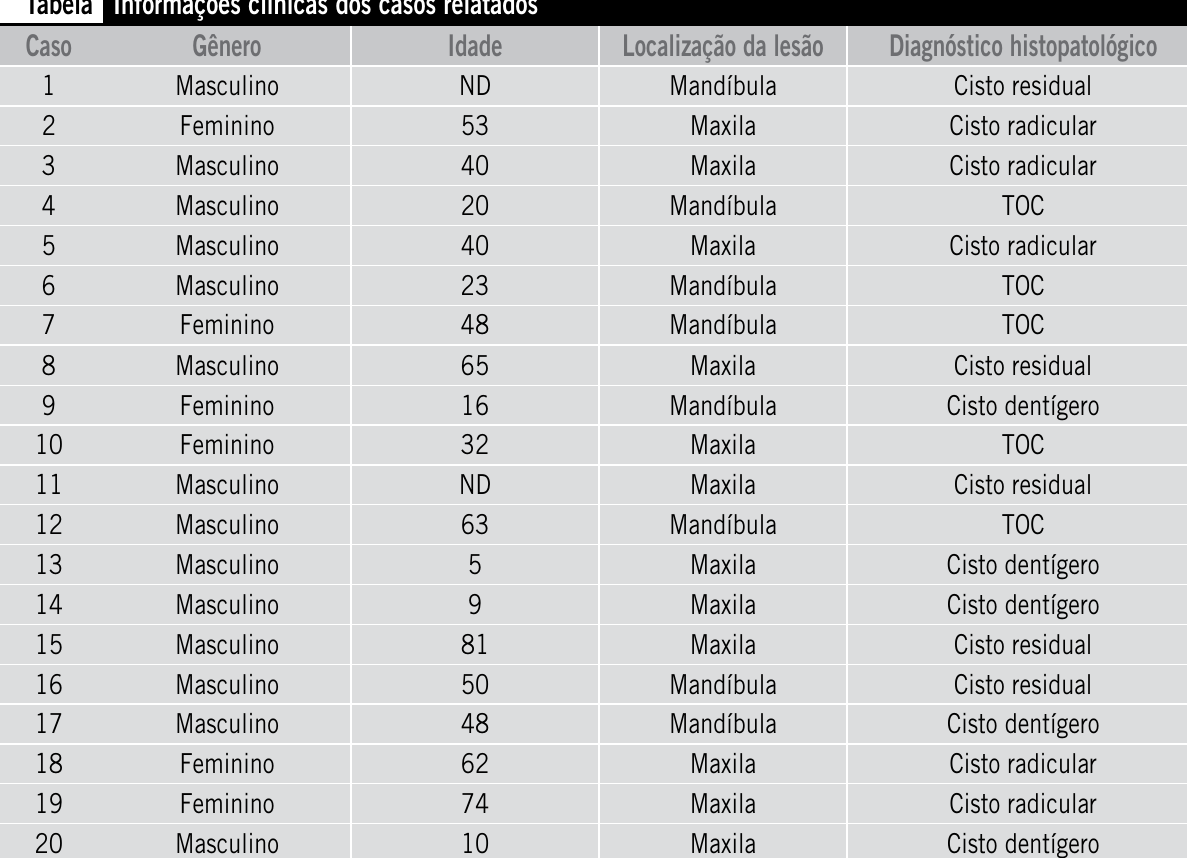
foi transferido para papel absorvente ( Figuras 2E e 2F ), colocado em um cassete histológico ( Figura 2G ) e fixado em solução de formol a 10% por 24 horas ( Figura 2H ). Após esses procedimentos, o material foi processado rotinei- ramente, seguindo os passos de desidratação (em